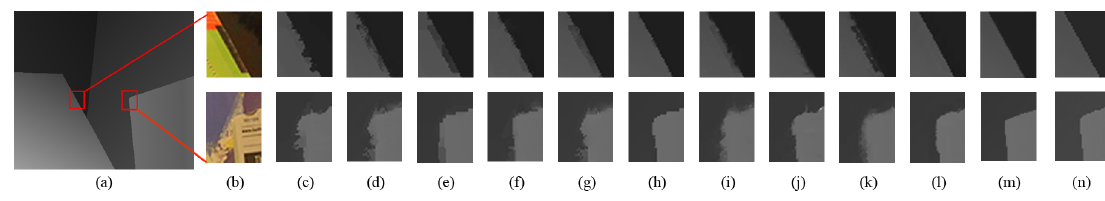
Figure 5. Example depth map SR results of Venus with two Regions Of (nterest (ROI). ( a ) Ground truth depth map, ( b ) color regions, and SR results of ( c ) Diebel et al. [22] (BP% = 1.16) , ( d ) JBU [11] (0.72) , ( e ) Lu et al. [23] (0.31) , ( f ) Kim et al. [24] (0.30) , ( g ) Jung [17] (0.59) , ( h ) Lo et al. [3] (0.16) , ( i ) Park et al. [26] (0.66) , ( j ) Ferstl et al. [27] (0.41) , ( k ) Choi et al. [18] (0.49) , ( l ) Lo et al. [21] (0.16) , ( m ) Our method (0.04) , and ( n ) the associated ground truth.